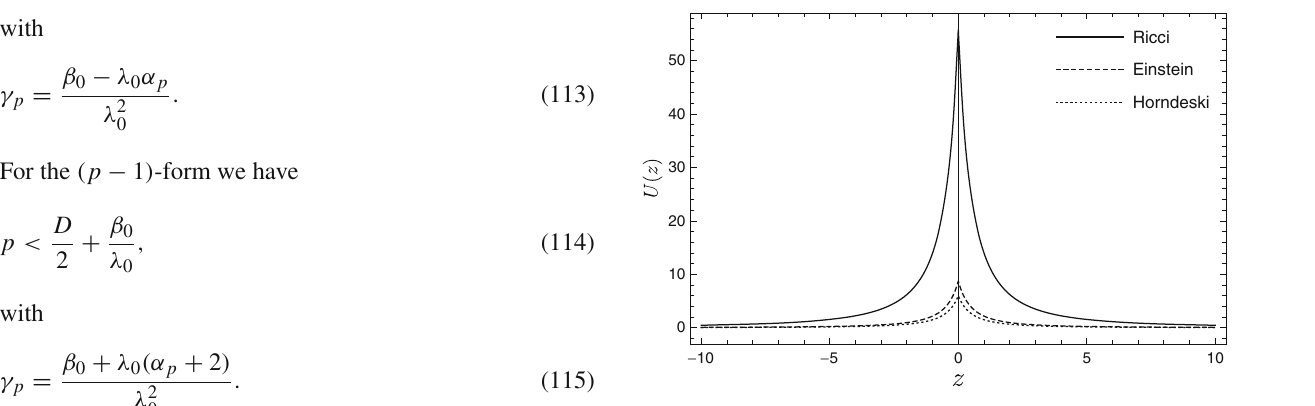
Fig. 10 Regular part of Schrödinger potential for a p -form field in Randall–Sundrum delta like scenario with k = 1 , D = 10 and p = 3 for Ricci, Einstein and Horndeski